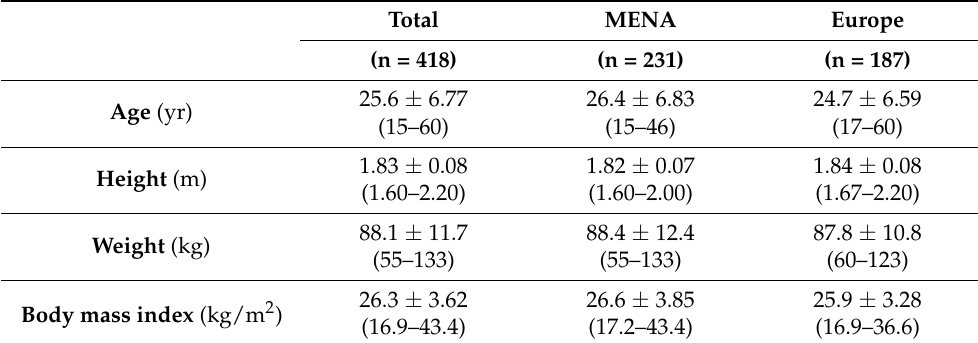
Table 2. Demographic and anthropometric characteristics of all participants (n = 418).